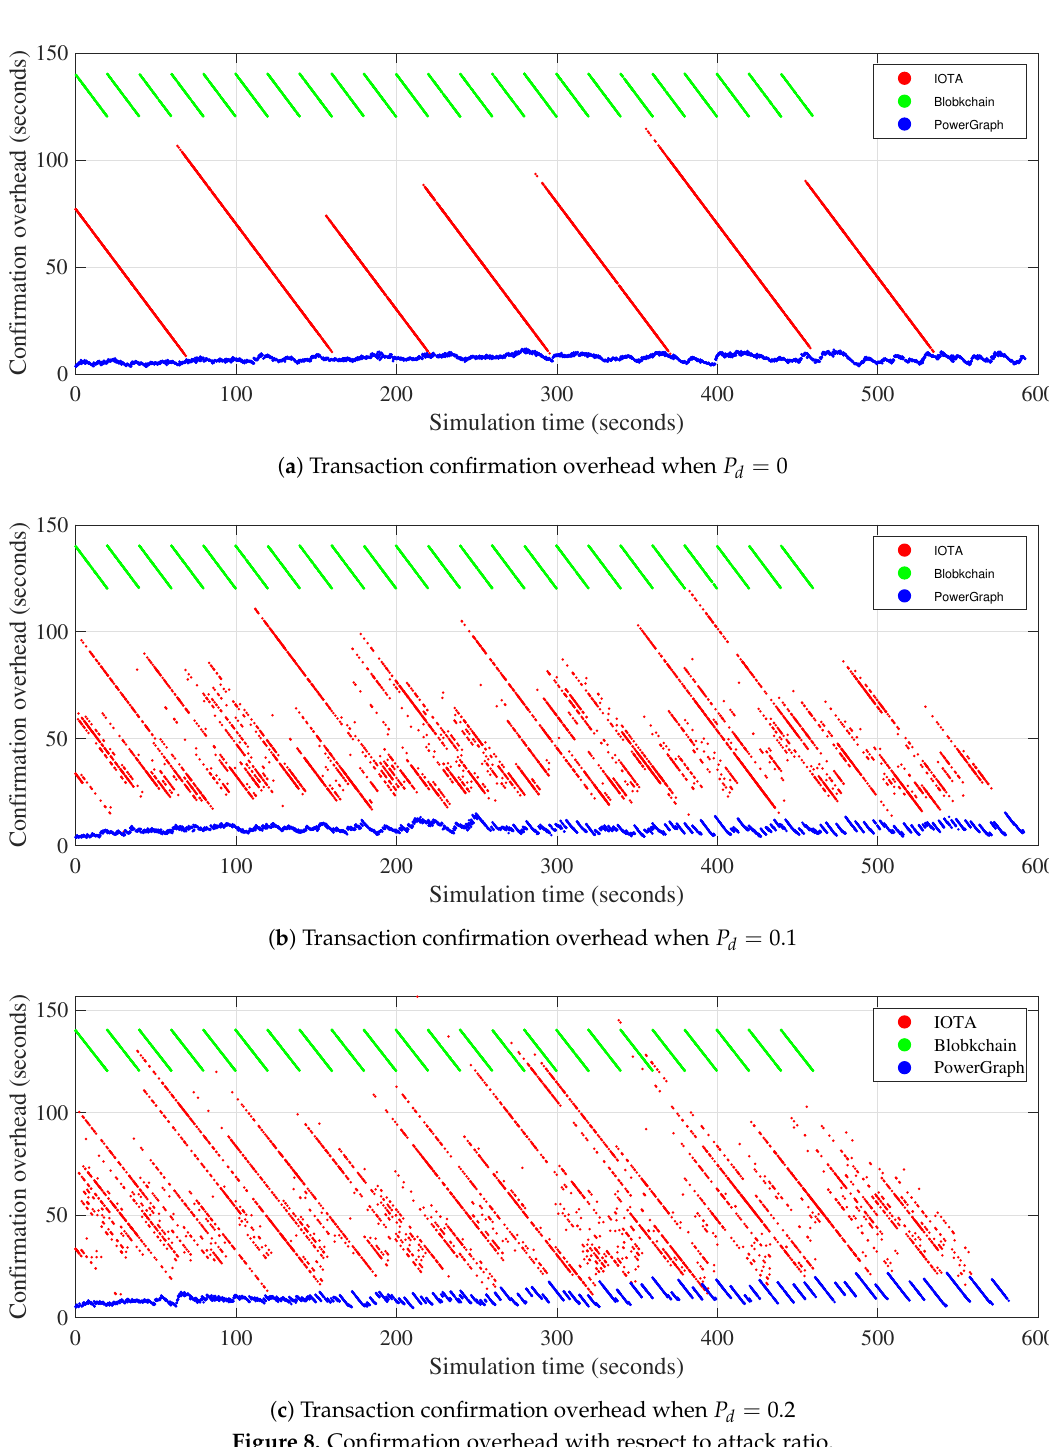
Figure 8. Confirmation overhead with respect to attack